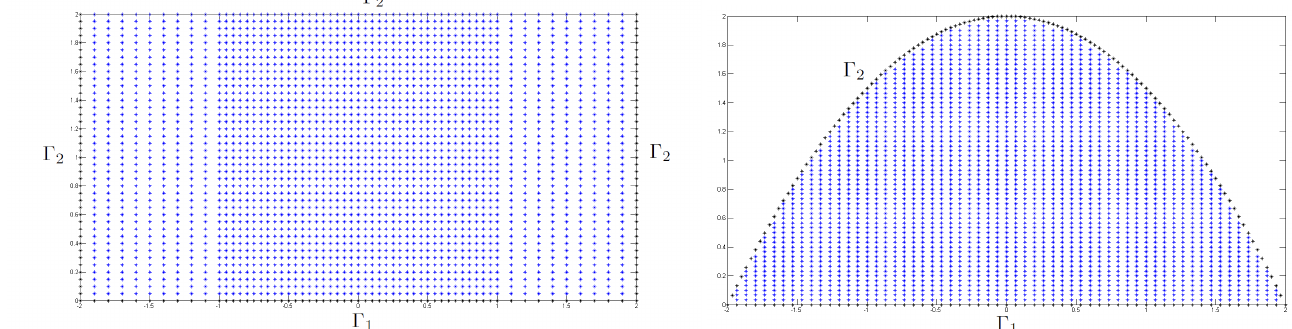
Figure 1. Clouds of nodes with irregular